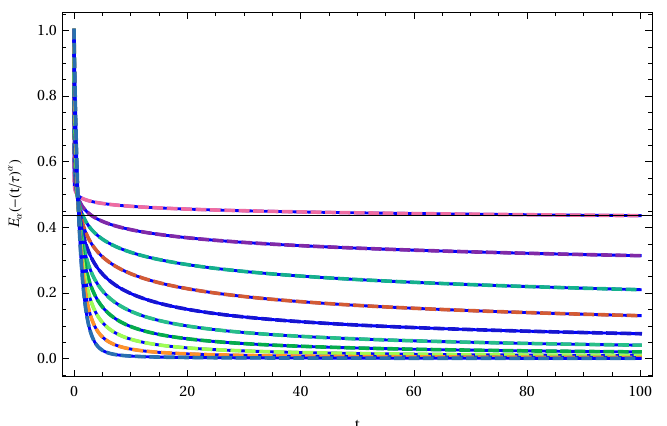
Figure 8. A variety of solutions of (88) for different values of α . From top to bottom on the right end of the graph, the α values vary between 0.05 and 1 in steps of 0.01. The solid line represents the Sinc inverse Laplace result, while the dashed line is the Mathematica implementation of E α ( − ( t / τ ) α ) . Parameters are χ 0 = 1, τ = 1, and N =